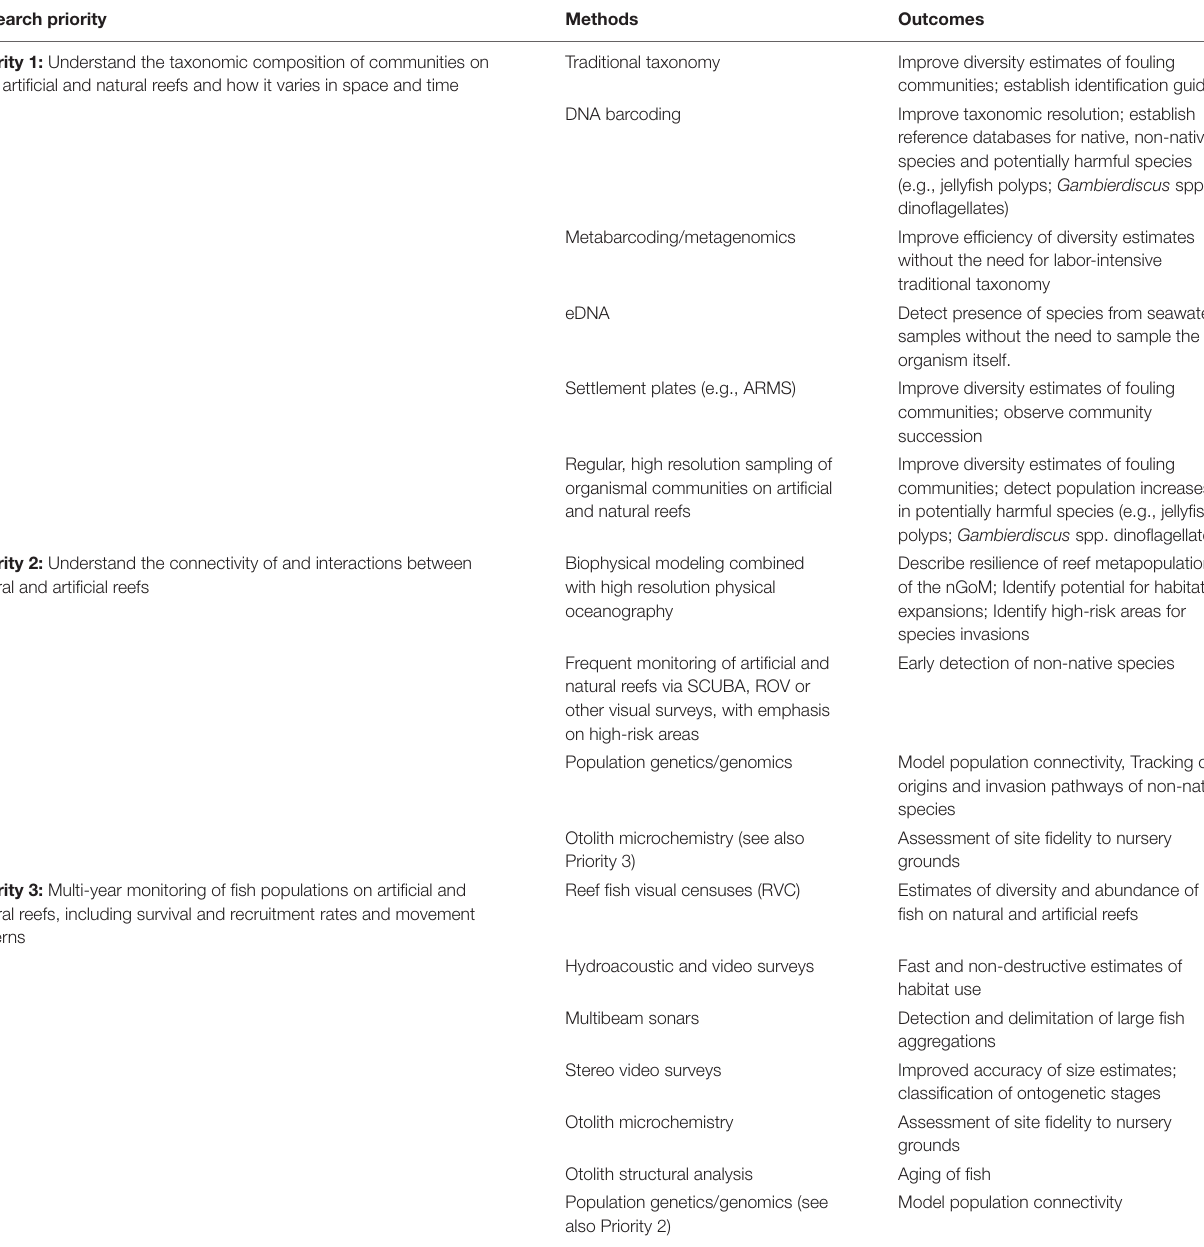
TABLE 1 | Proposed research priorities for artificial reefs in the nGoM, methods to address the priorities and their prospective outcomes. Research